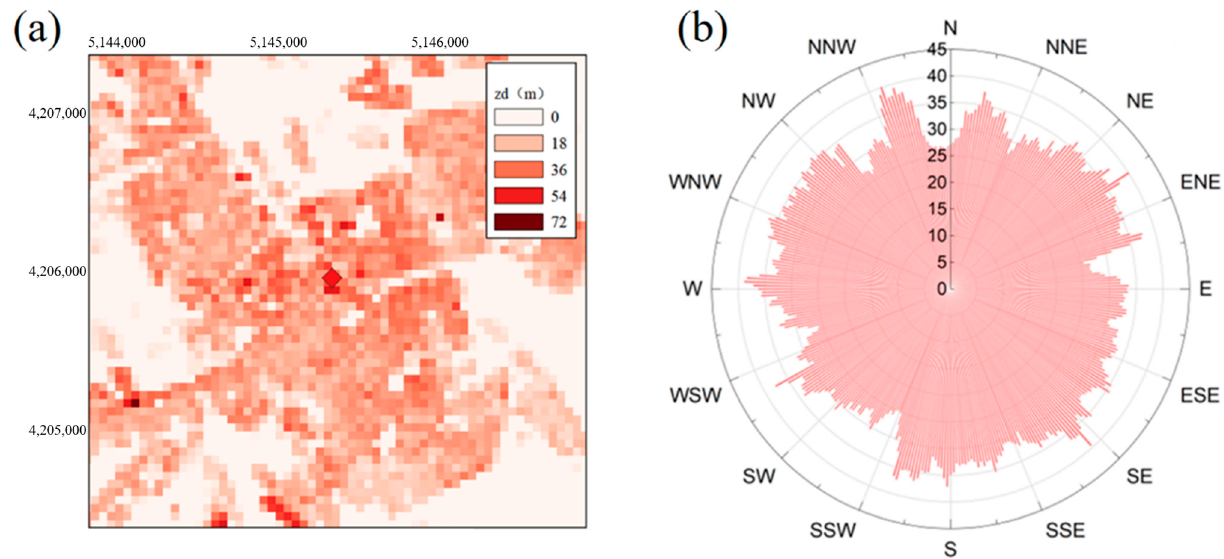
Figure 2. ( a ) The 50 m × 50 m zero-plane displacement (zd) of the study area was calculated to ( b ) the zd in different wind directions for each degree by UMEP.